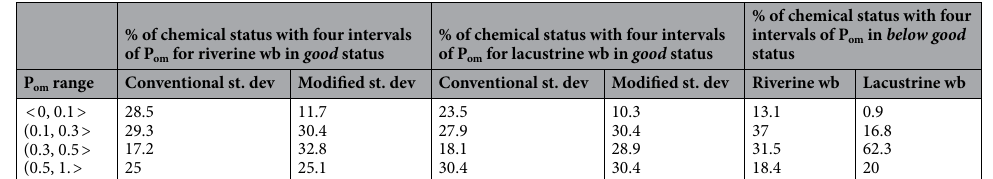
% of chemical status with four intervals of P om in below good % of chemical status with four intervals % of chemical status with four intervals of P om for riverine wb in good status status of P om for lacustrine wb in good status P om range Conventional st. dev Modified st. dev Conventional st. dev Modified st. dev Riverine wb Lacustrine wb < 0, 0.1 > (0.1, 0.3 > (0.3, 0.5 > (0.5, 1. Table 3. Probability of misclassification of chemical status (level 4) for riverine and lacustrine water bodies for the years 2016–2018. Comparison of the probability of misclassification based on conventional and modified std. dev*). *P om s for wbs in below good chemical status uncertainty of the assessment was not affected by the method of calculation of st. dev.